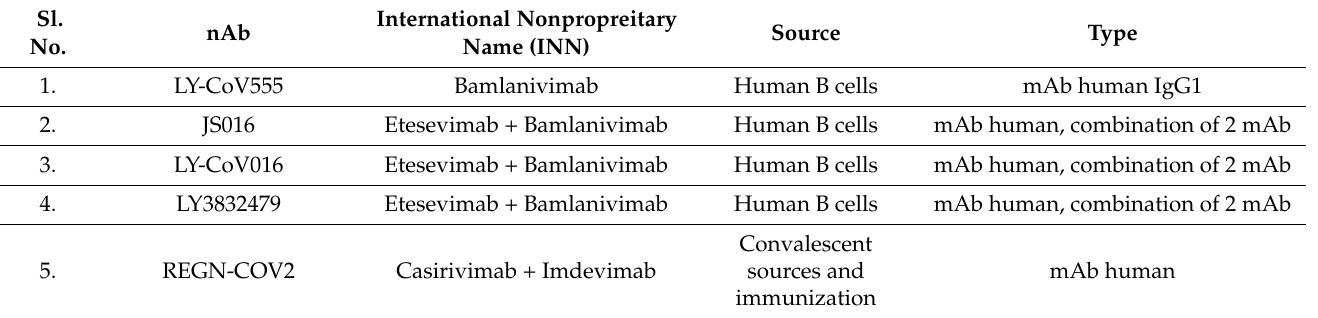
Table 3. Different neutralizing antibodies which are in the pre-clinical